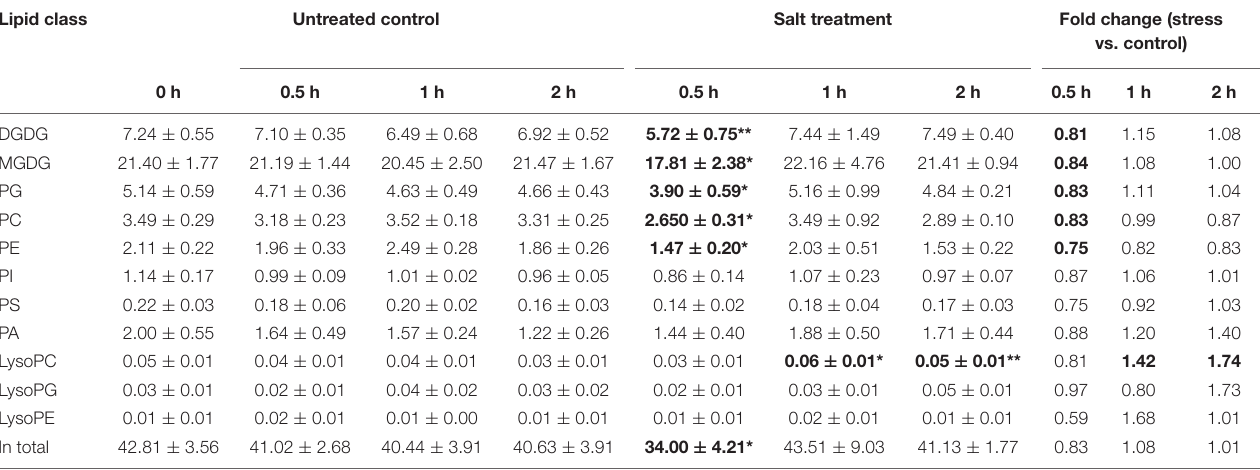
TABLE 1 | Changes in major lipid classes of soybean C08 leaves under salt treatment. Lipid class Untreated control Salt treatment Fold change (stress